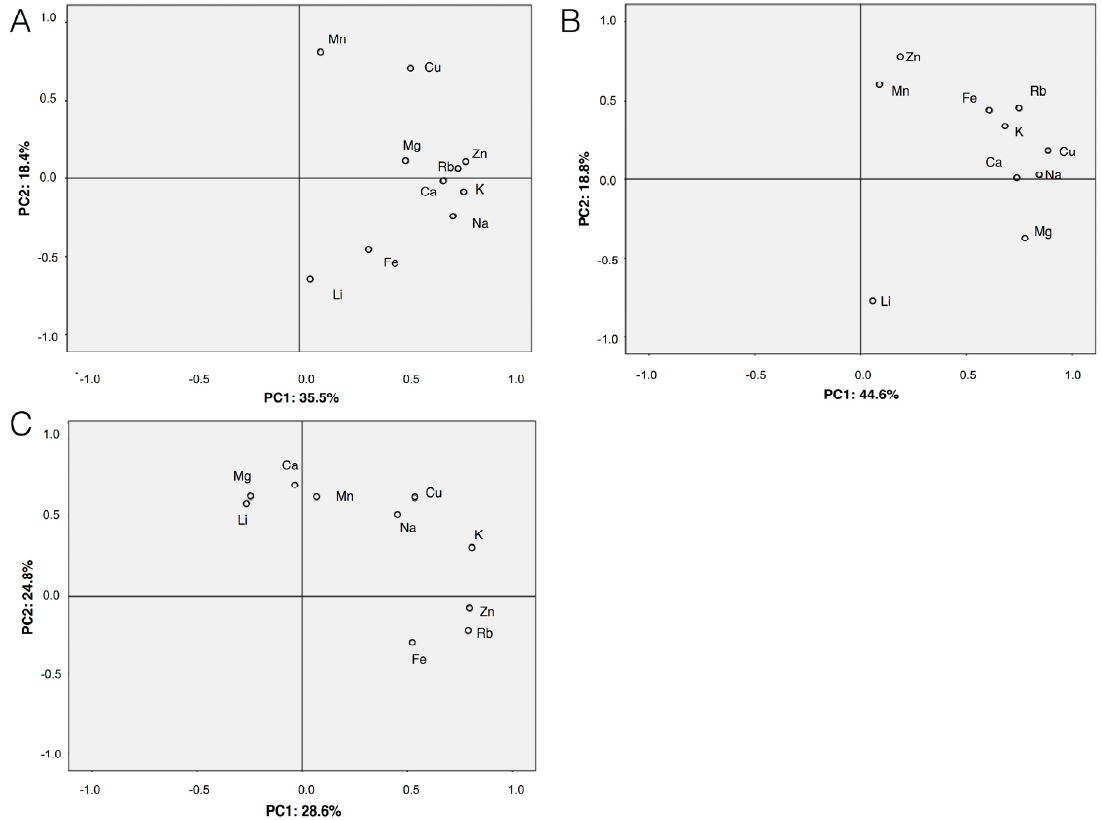
Figure 1. Projection of concentrations of chemical elements in saliva of patients with untreated periodontitis ( A ), with treated periodontitis ( B ) and healthy controls ( C ) on the plane of the first two principal components (PC1 and PC2).